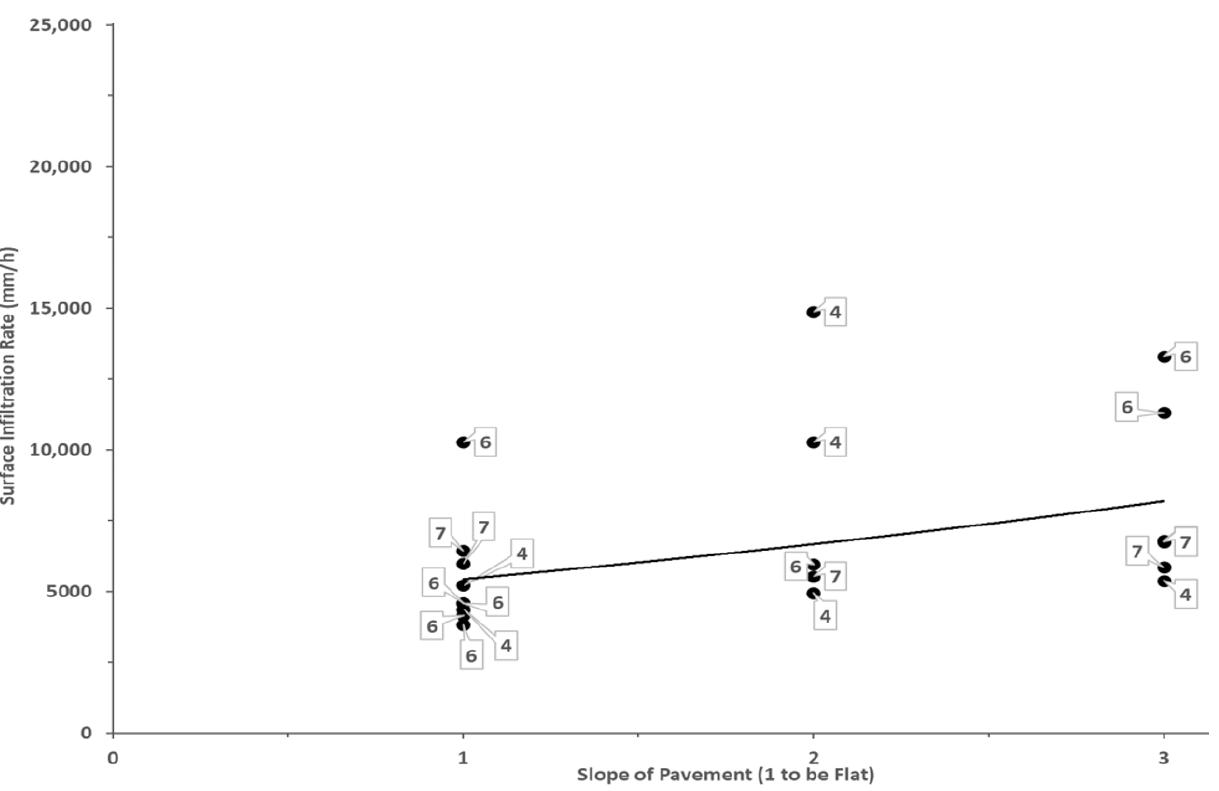
Figure 6. Infiltration rate versus slope of pavement. The age of the pavement is between 4 and 7 years old. The call-out boxes show the age of the pavement.